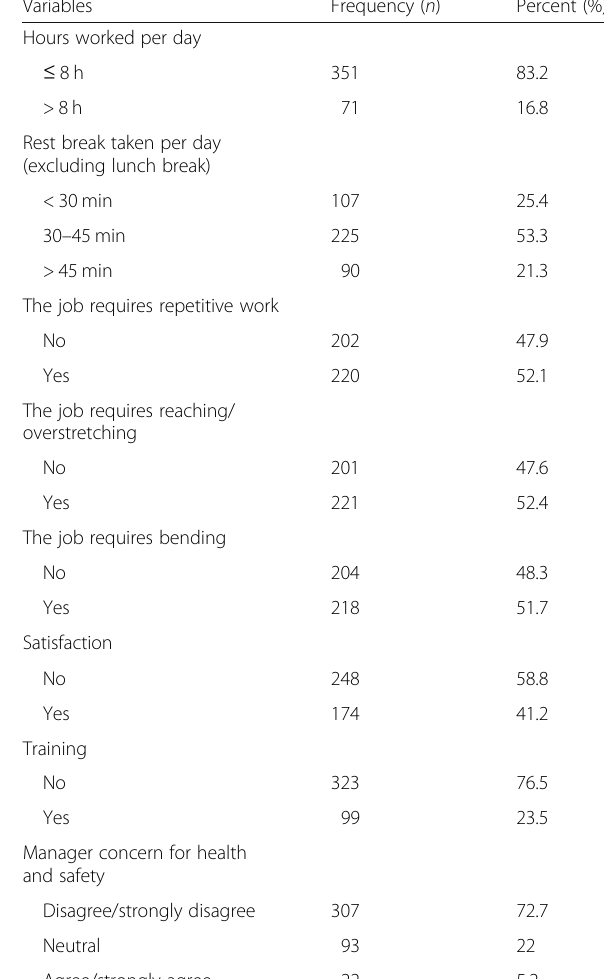
Table 1 Socio-demographic and personal characteristics of the study participants, Northwest Ethiopia, 2017 ( n = 422)